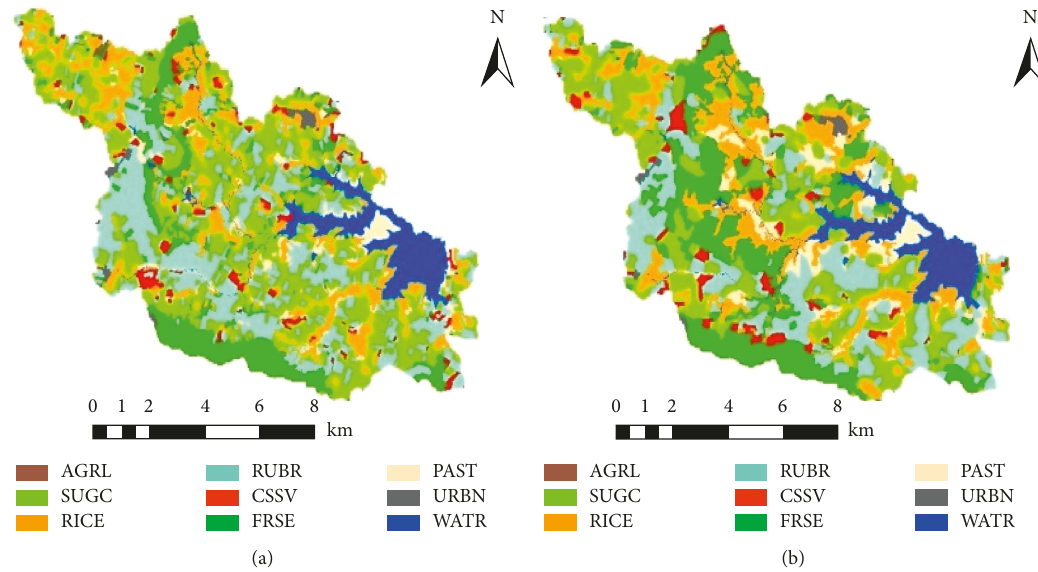
Figure 6: The validation results of actual land use (a) and simulated land use (b) for the Huay Ling Jone